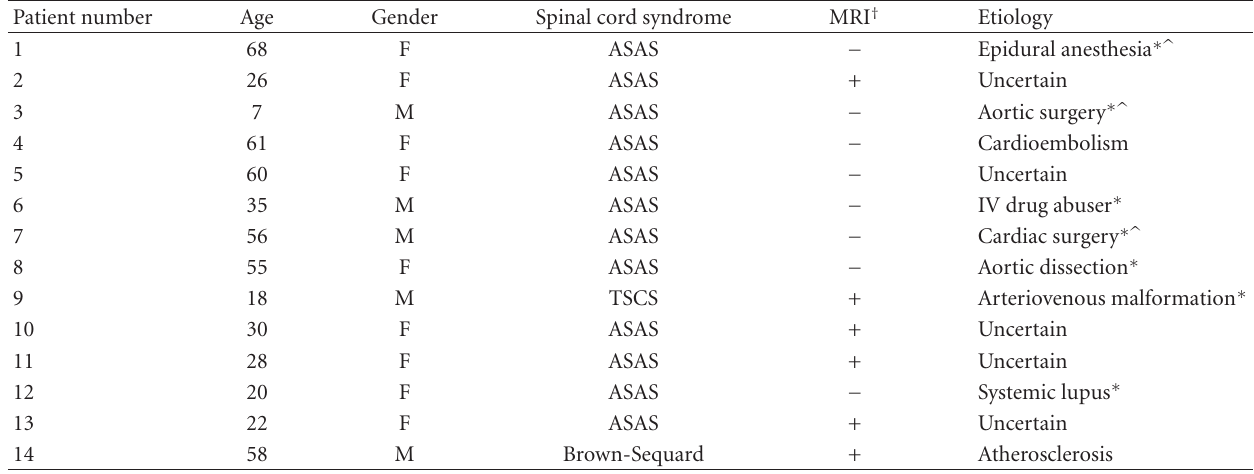
Table 1: Clinical characteristics of 14 patients with spinal cord